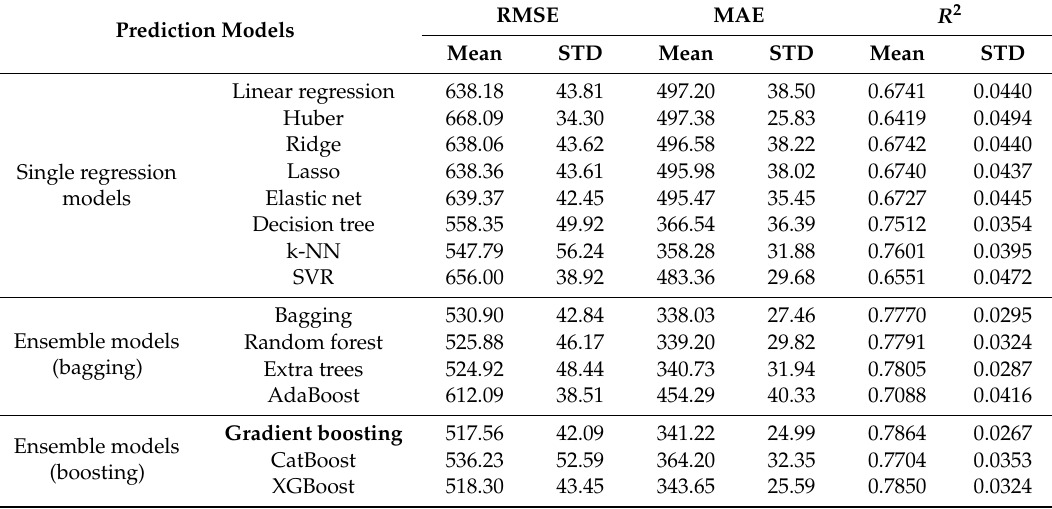
Table 7. Comparative statistics of prediction models based on observation and forecast weather information using 10-fold cross-validation.